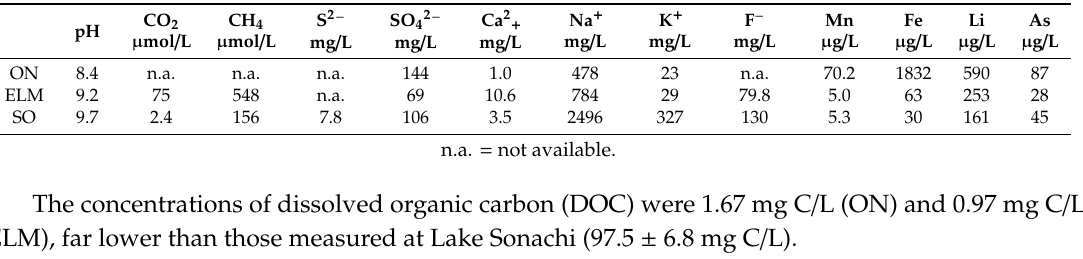
Table 2. Geochemical analysis of the waters sampled during the present study.